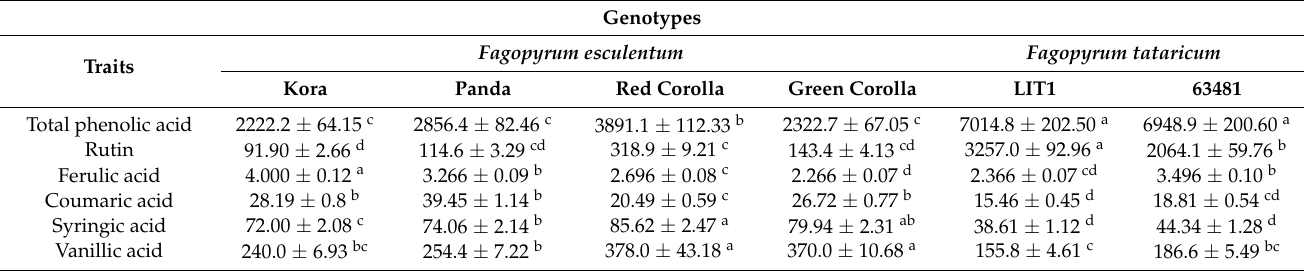
Table 1. The phenolic acid content of buckwheat genotypes (mg · kg − 1 d.w).